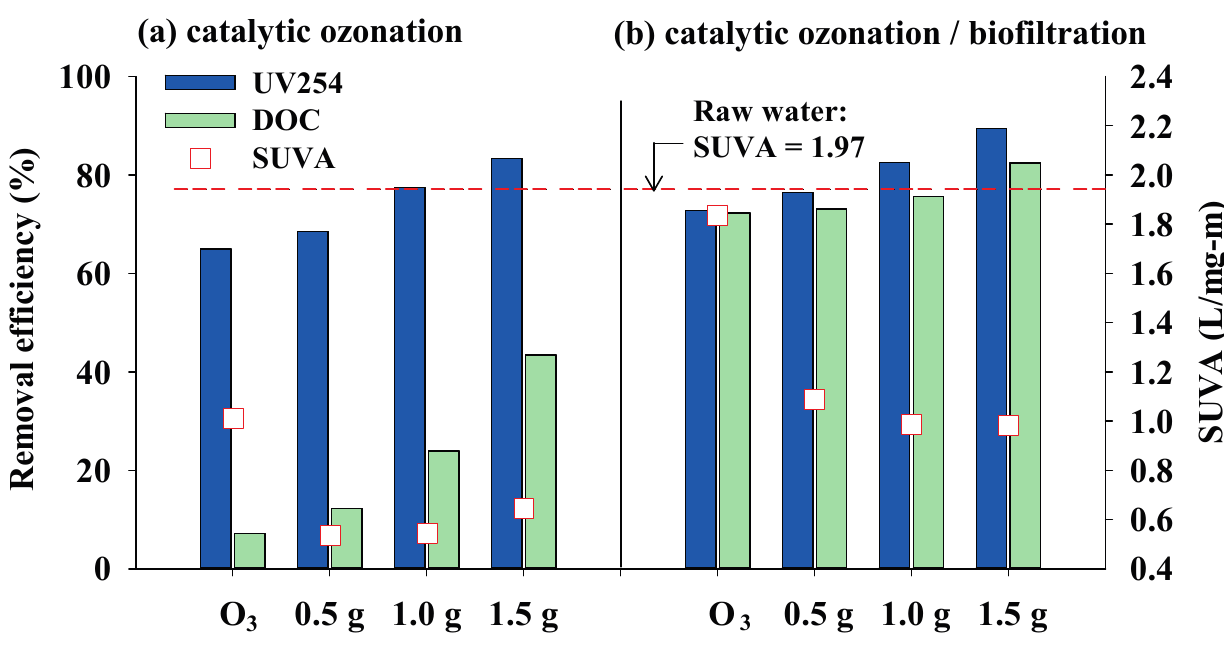
Figure 5. Removal efficiency of DOC and UV254 with various catalyst dosages for ( a ) catalytic ozonation alone and ( b ) catalytic ozonation followed by biofiltration (ozone concentration: 2.5 mg·L − 1 ; gas flow: 50 mL·min − 1